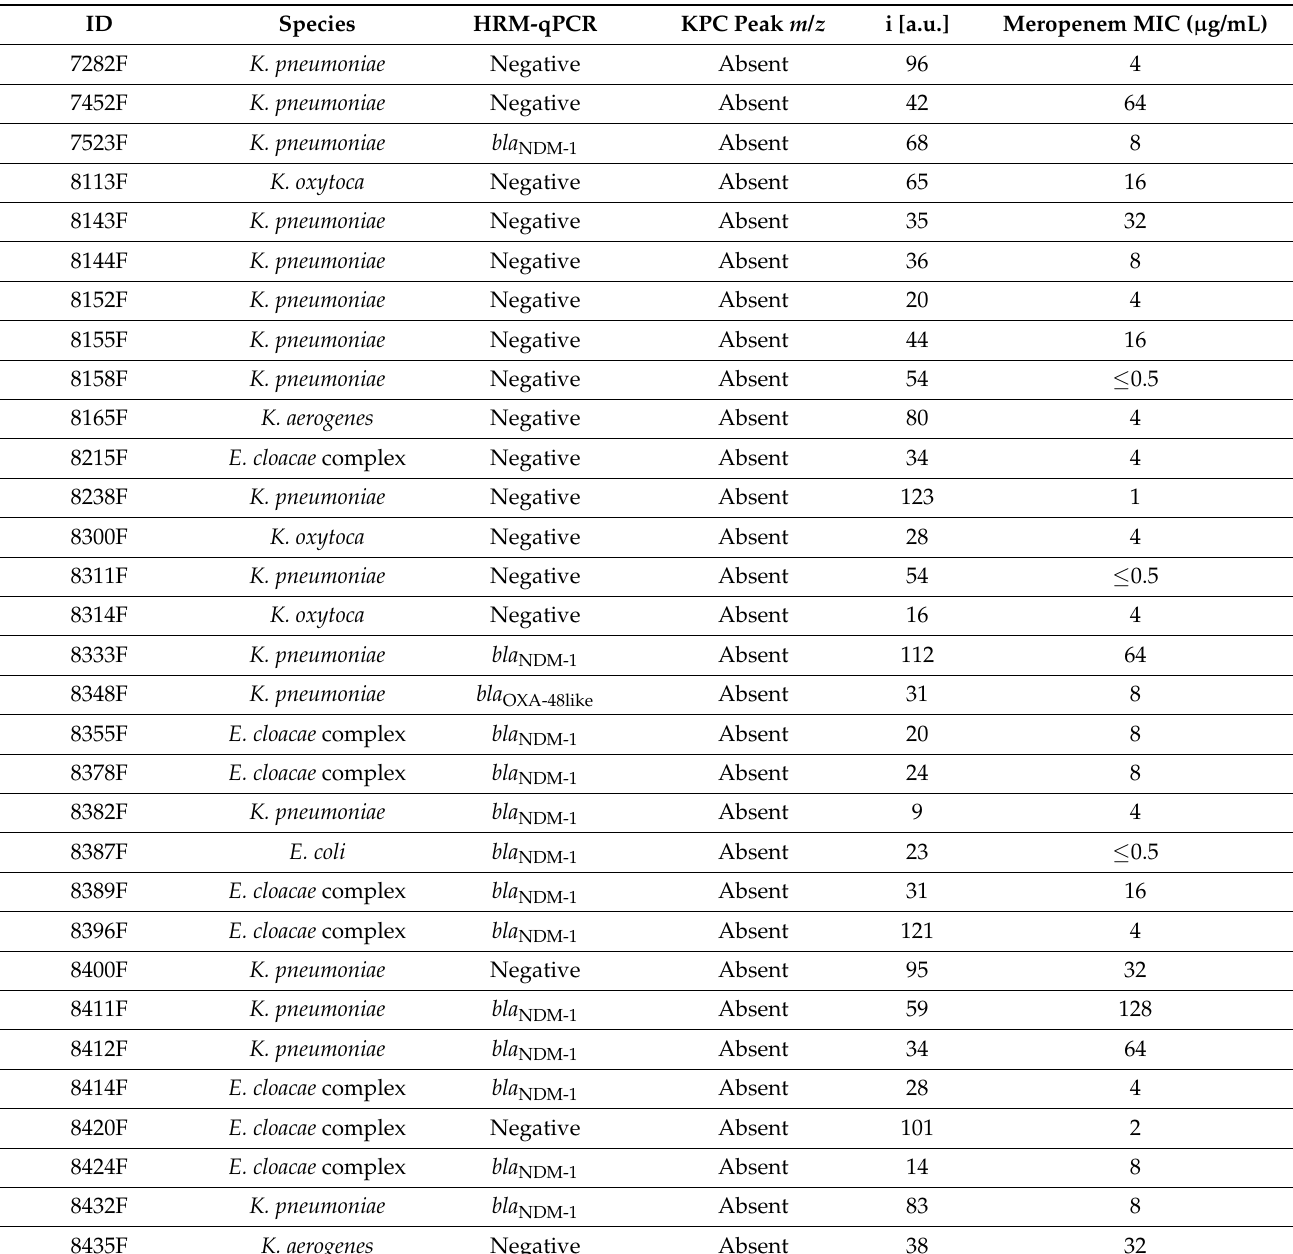
Table 2. Characteristics of bla KPC -negative bacteria used to inoculate blood cultures for KPC detection and results of spectra analysis by direct inspection and determination of